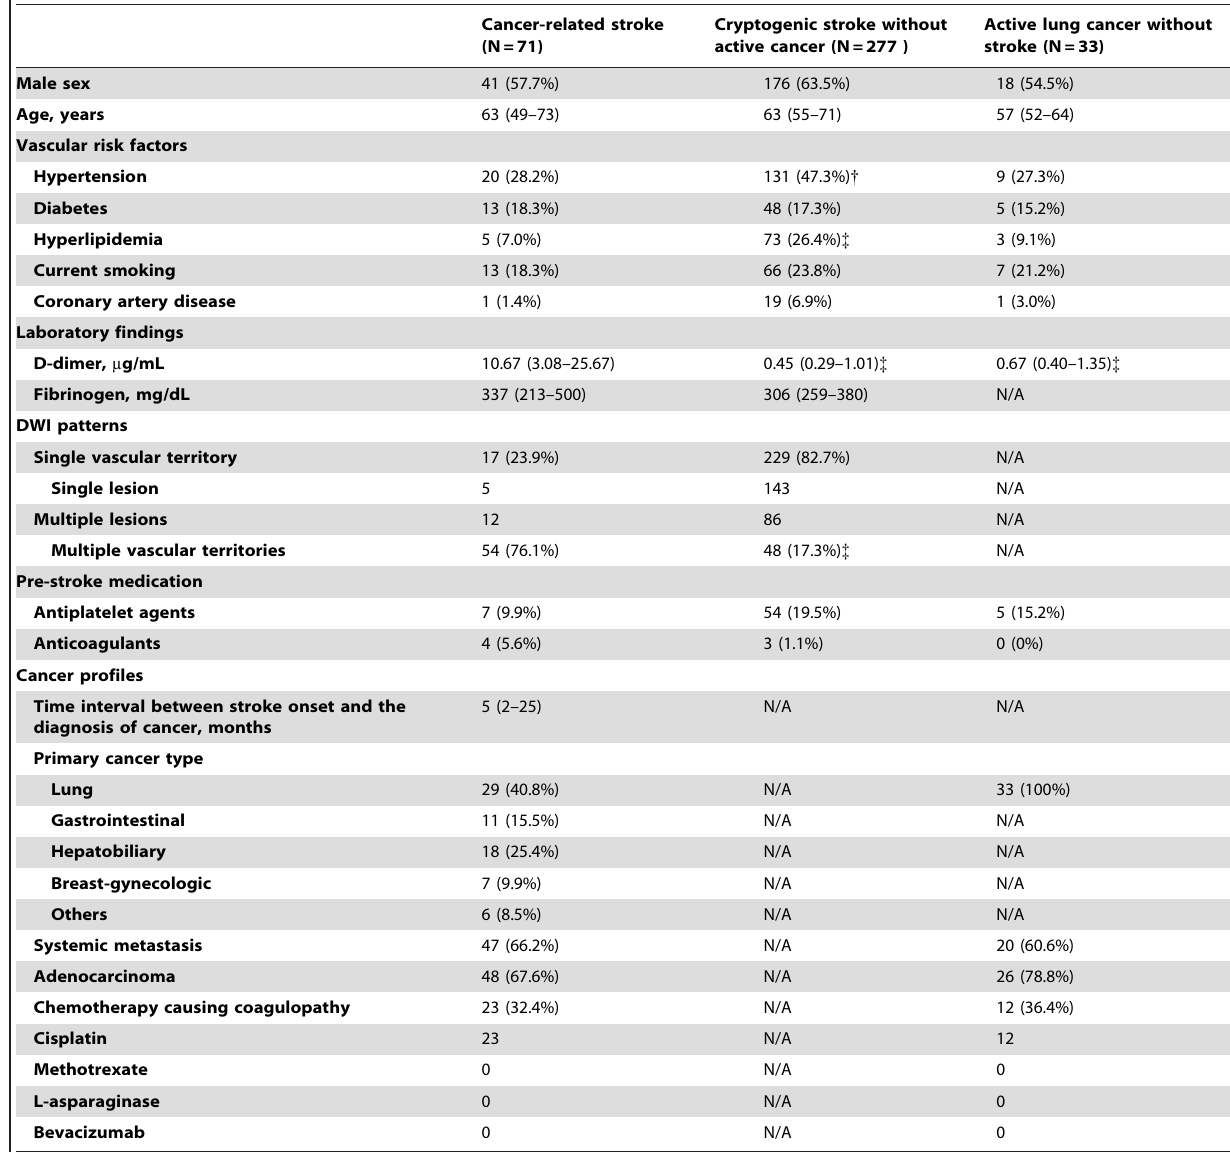
Table 1. Baseline